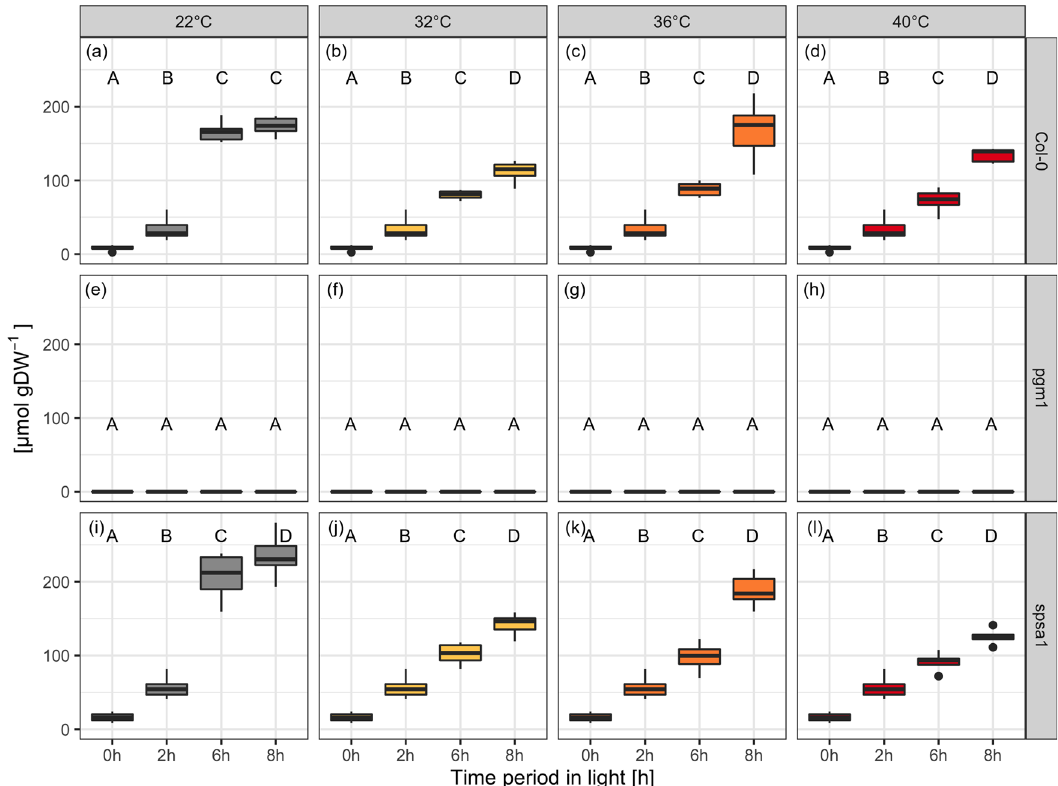
Fig. 5 Starch amounts during short-day transient heat exposure in glucose equivalents. a – d Col-0 ( n ≥ 5); e – h pgm1 ( n ≥ 3); i – l spsa1 ( n ≥ 5). Gray: 22 °C experiment; yellow: 32 °C experiment; orange: 36 °C experiment; red: 40 °C experiment. The temperature was set to 22 °C between 0 – 2 h and 6 – 8 h. The temperature was transiently increased between 2 and 6 h. Box-and-whisker plots: center line, median; box limits, upper and lower quartiles; whiskers, 1.5× interquartile range; points, outliers. Capital letters indicate groups of signi fi cance within genotype and condition (ANOVA, P < 0.05). Experimental data are provided in Supplementary Data